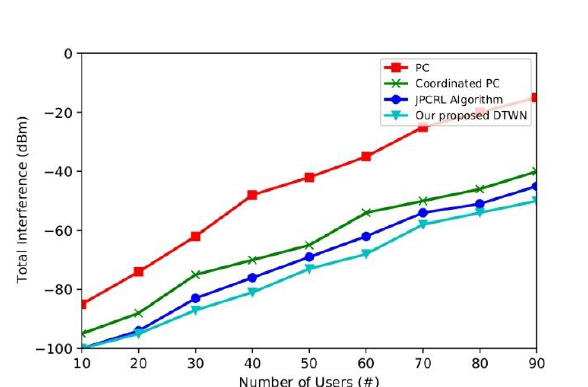
Figure 10. Total interference(dBm) versus number of